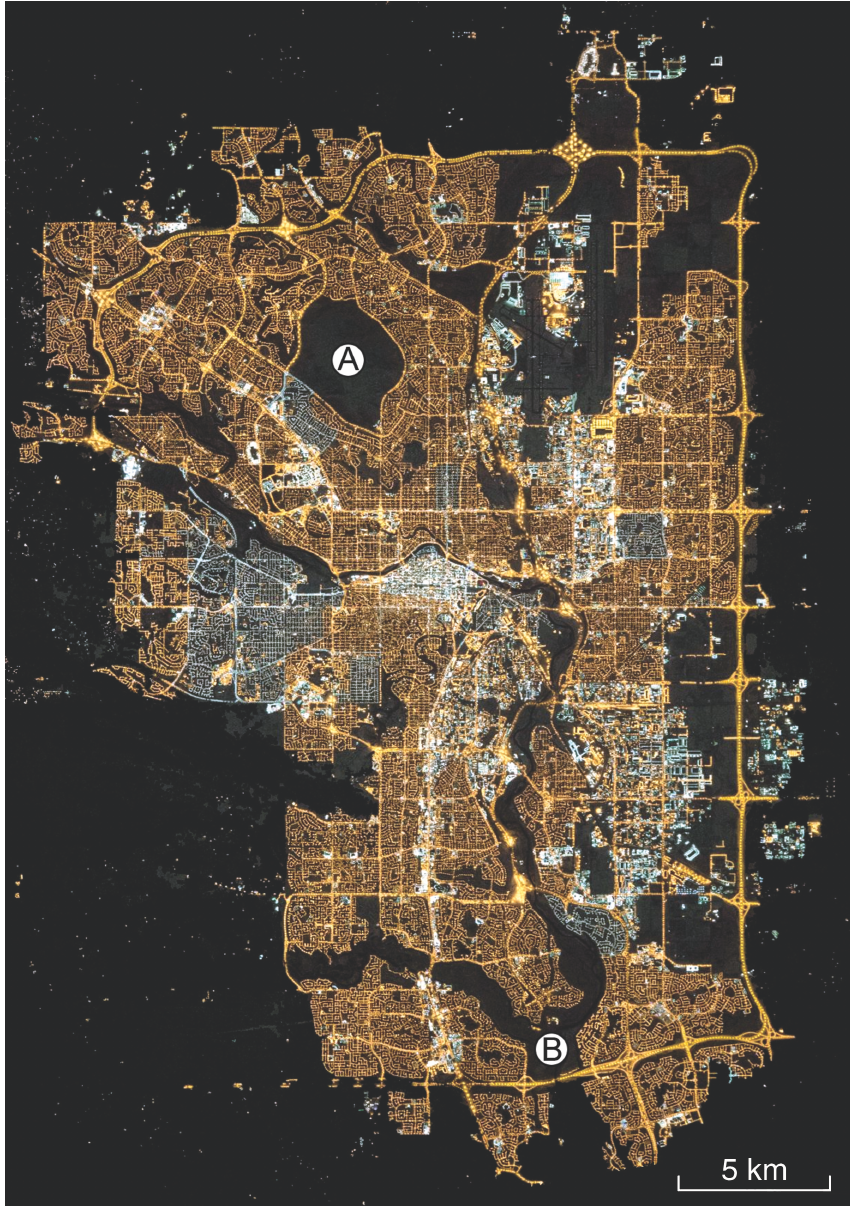
Figure 2. National Aeronautics and Space Administration photo ISS045-E-155026 of the city of Calgary, Canada, obtained by an astronaut aboard the International Space Station at 0707 UTC on 28 November 2015. The true-color image is oriented according to the usual cartographic convention with north up and east right, and a five-kilometer scale bar is provided in the lower right corner. The courses of major waterways, including the Bow River, are conspicuous as a series of sinuous silhouettes seen against the surrounding city lights. The image also shows two prominent protected areas within the city: Nose Hill Municipal Park (A) and Fish Creek Provincial Park